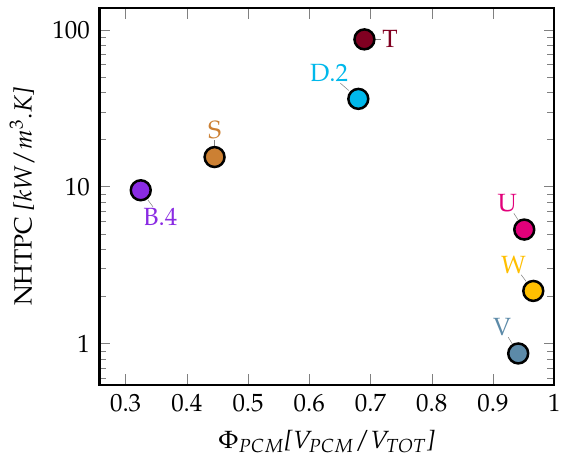
Figure 3. Calculated NHTPC vs. Φ PCM for the references concerning AHEX and CTB in LHES unit configurations in logarithmic